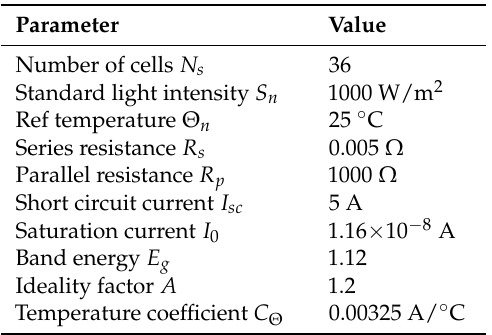
Table 1. Parameters of the PV